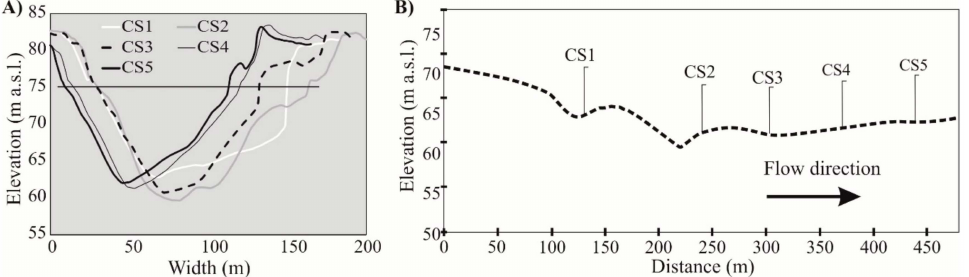
Figure 6. Cross-sectional channel profiles ( A ) and longitudinal thalweg profile ( B ) at the Csanytelek South study